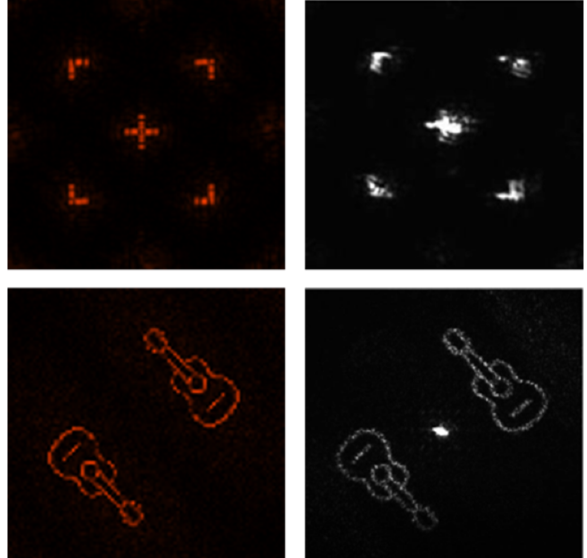
Figure 6. Comparison between the theoretical ( left ) and experimental ( right ) far ‐ field diffracted intensity profiles of the CGHs. Top, crosshair target visor and bottom, guitars.